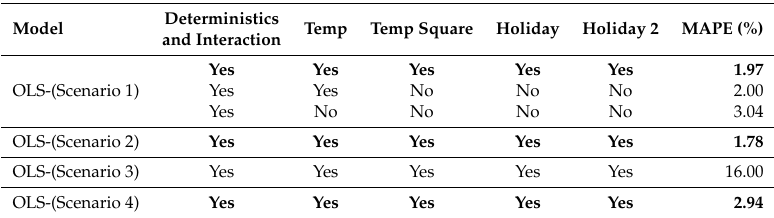
Table 2. Effect of variables on MAPE: simple Ordinary Least Square (OLS).